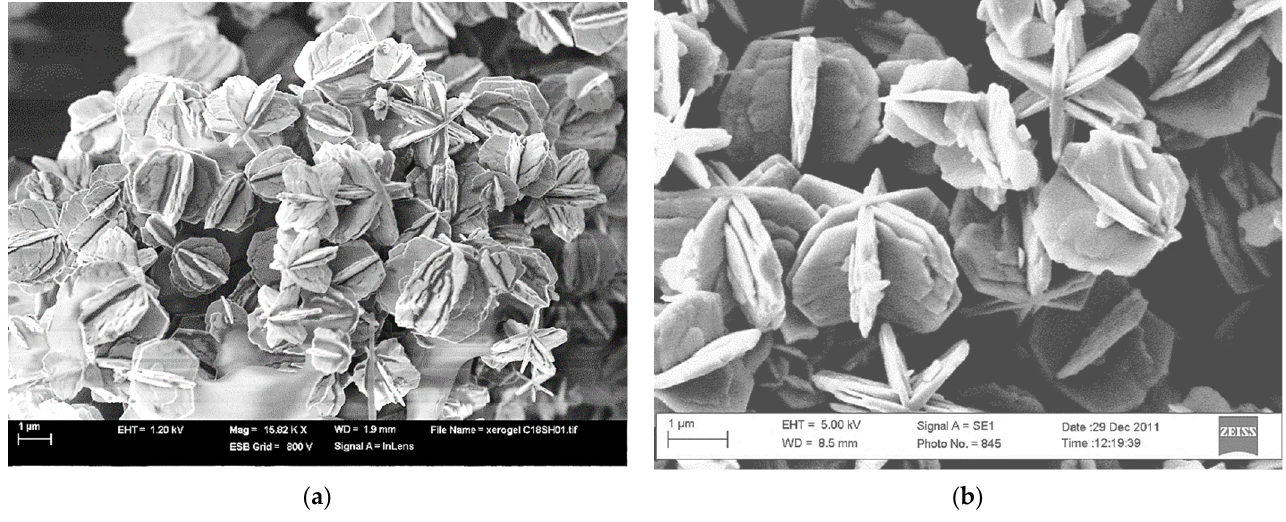
Figure 8. SEM micrographs of vanadium oxide V 6 O 11 rotationally symmetric six-folds (VOx-NC): ( a ) clustered V 6 O 11 vanadium oxide six-folds; ( b ) vanadium oxide six-folds, star-fruit morphology.